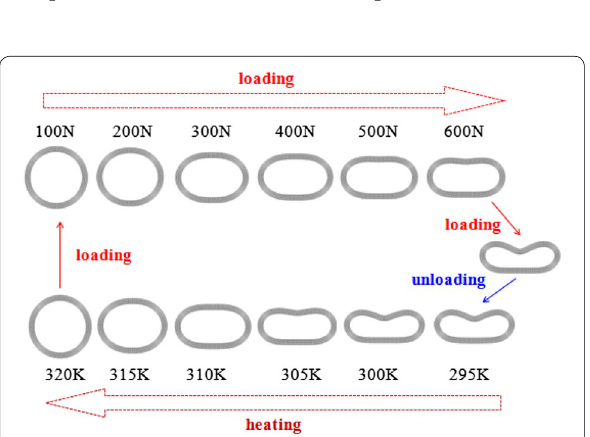
Figure 13 Shape changing process of SMA cirque in a loading-unloading-heating